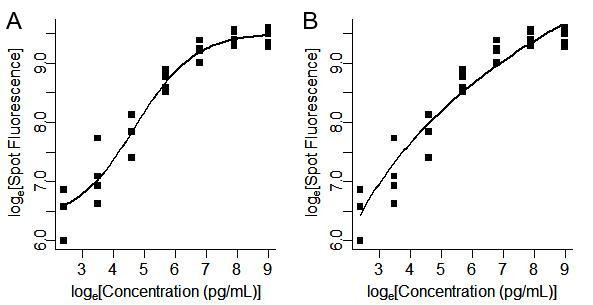
Candidate standard curves A review of the graphs of a four-parameter logistic curve (A) and a power law curve (B) suggests that the former shows higher fidelity to the data and is a better choice for the standard curve in this case.